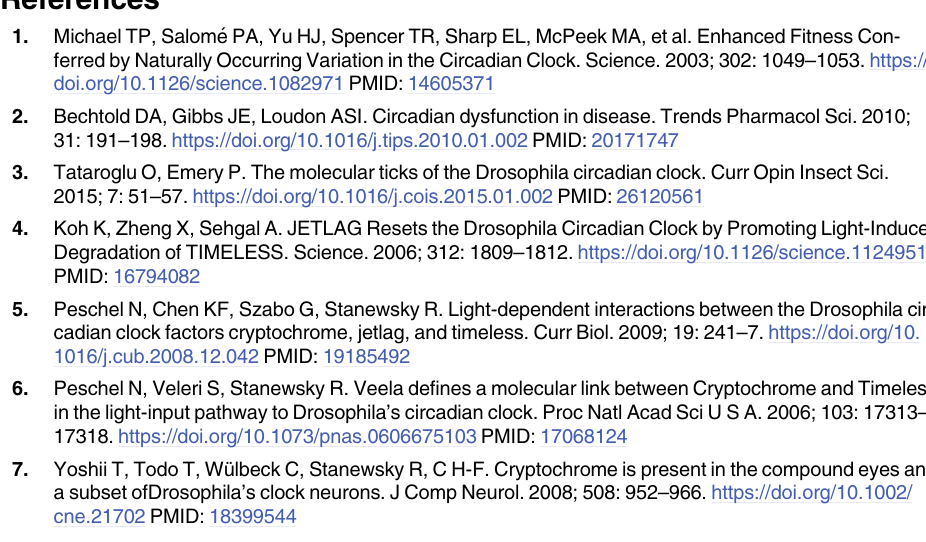
containing all data used for generating main and supplemental Figure graphs as well as